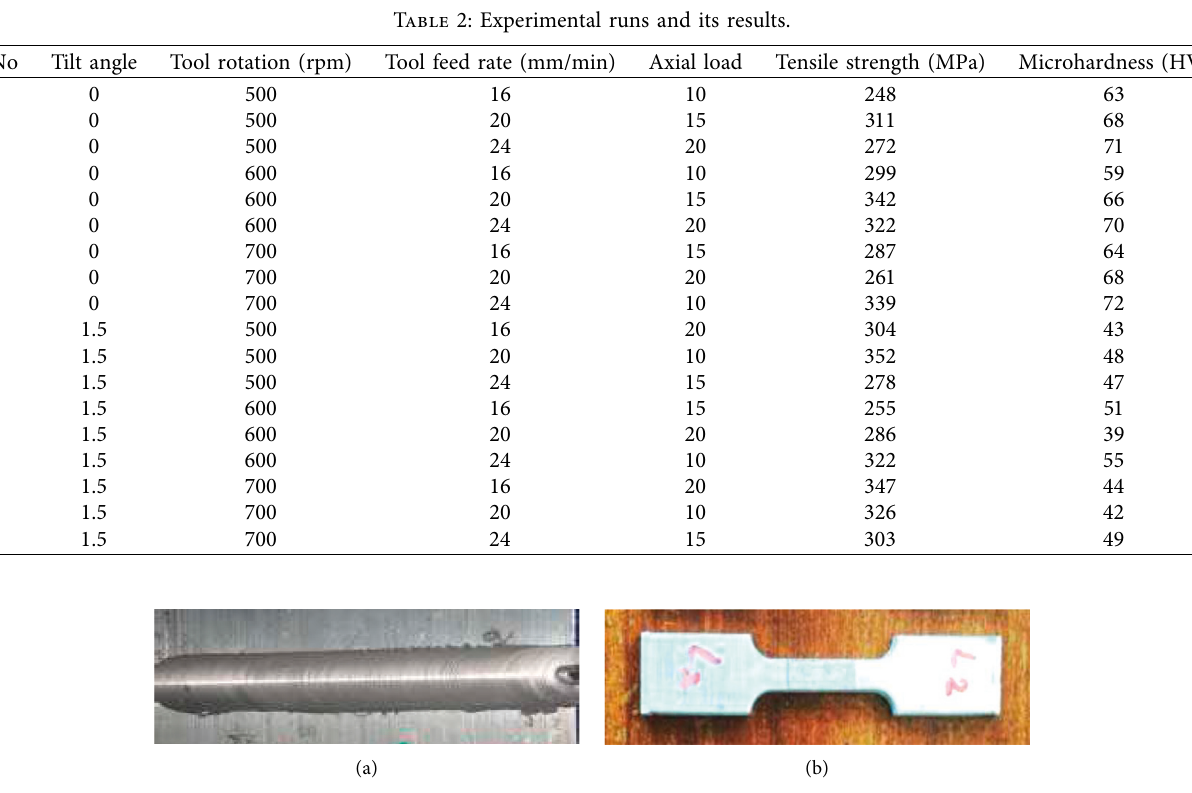
Figure 1: (a) Visual inspection of the FSW joint. (b) FSW tensile specimen.